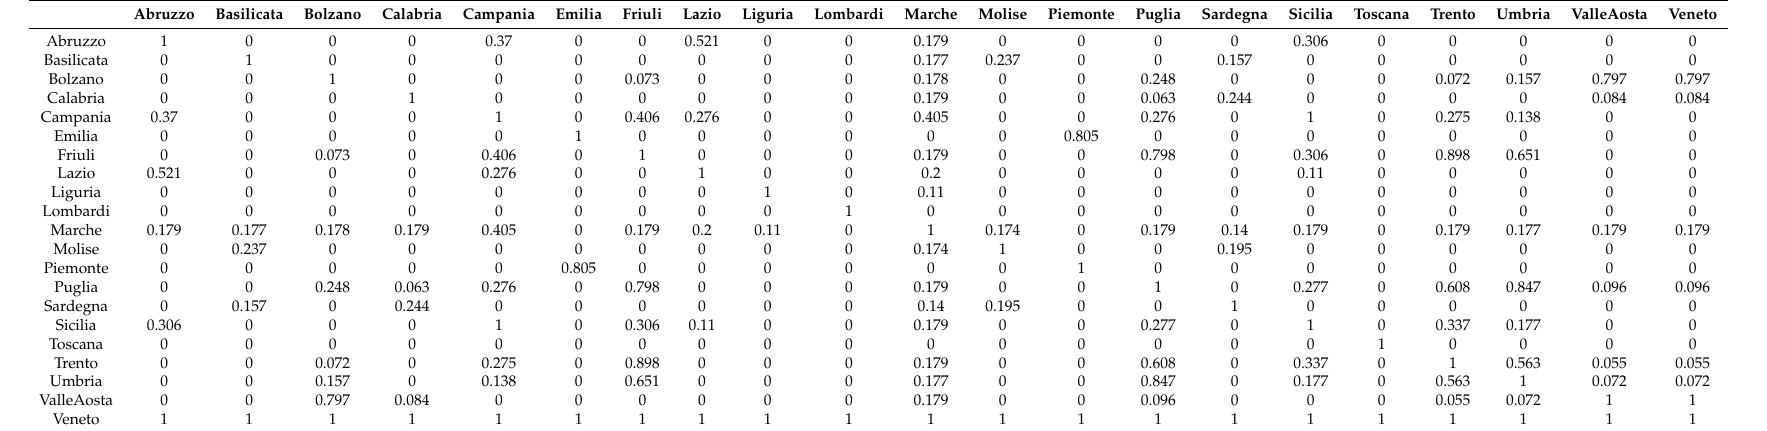
Table A11. Similarity values of Intensive Care network in the fourth week.